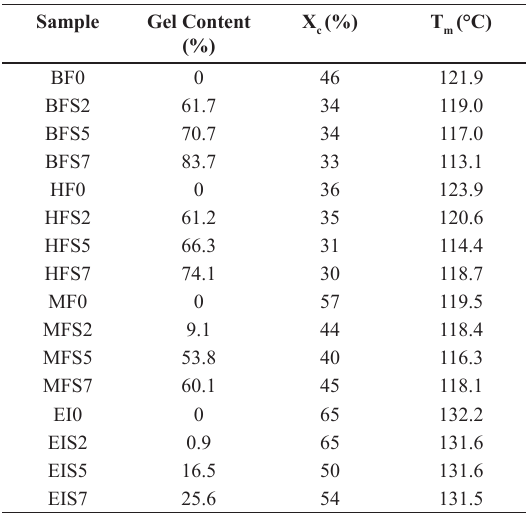
Table 2. Gel content and thermal properties of PEX samples. Sample